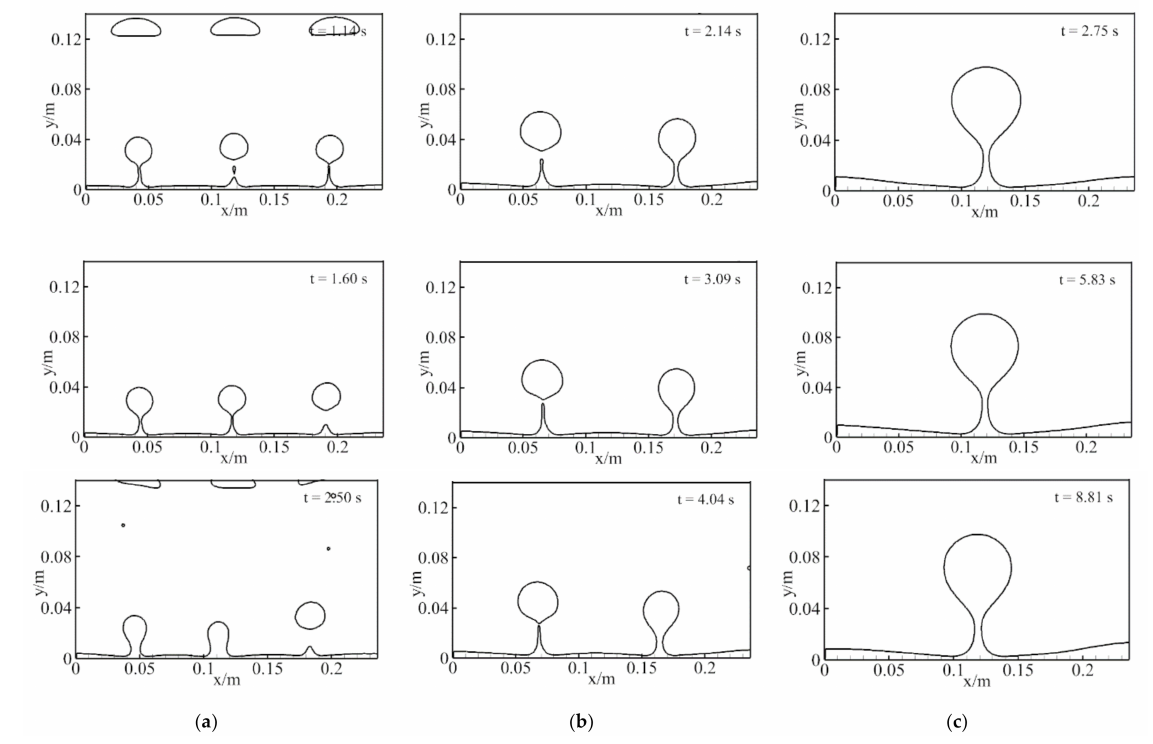
Figure 10. The bubble detachment at different gravity levels when H 0 = 5 kA/m. ( a ) g / g e = 1.0, ( b ) g / g e = 0.44, and ( c ) g / g e = 0.11.